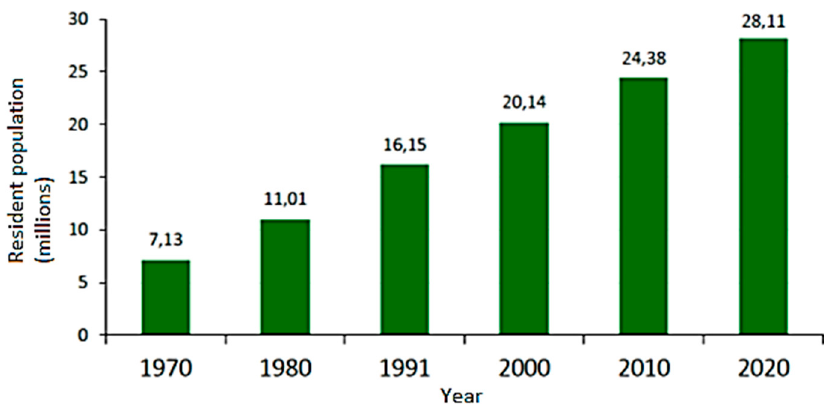
Figure 4. Amazon Brazilian population evolution between the decades. Source: [21].